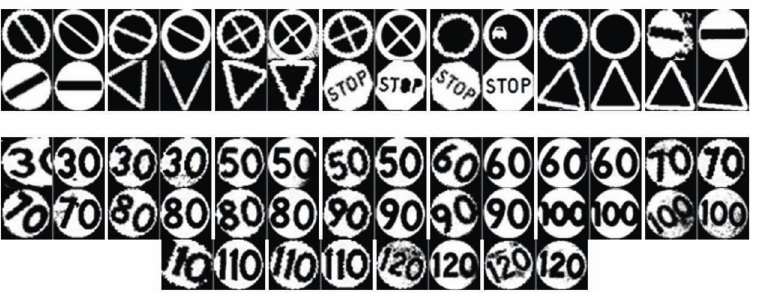
Figure 11. A number of correctly classified rotated